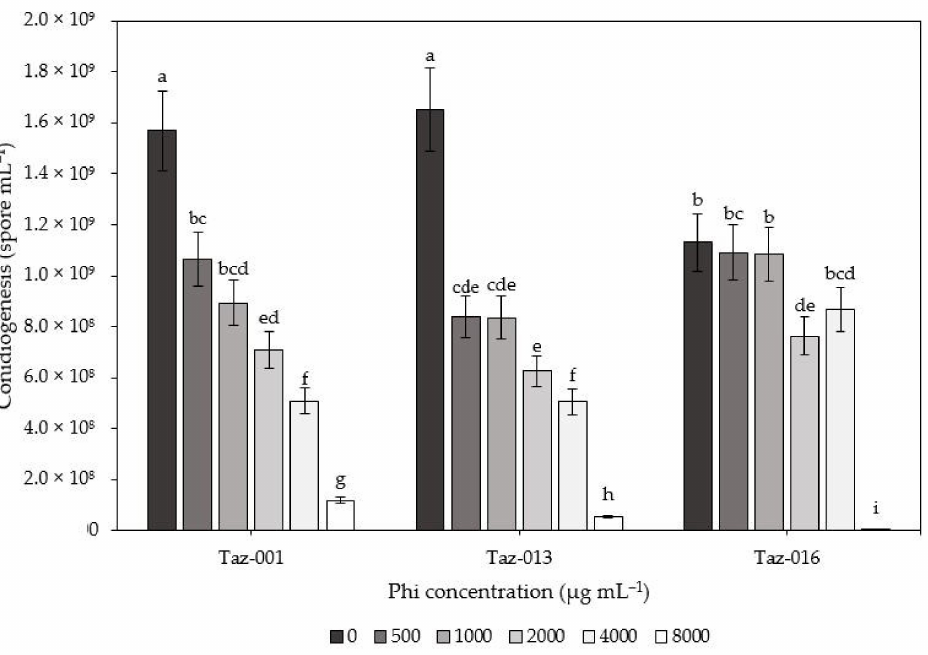
Figure 2. Conidiogenesis of Trichoderma sp. isolations (Taz-001, Taz-013 and Taz-016) determined as the number of spores per mL established in PDA medium supplemented with different concentrations of phosphite (Phi). Means with different letters indicate significant differences among treatments (Fisher’s test; α =